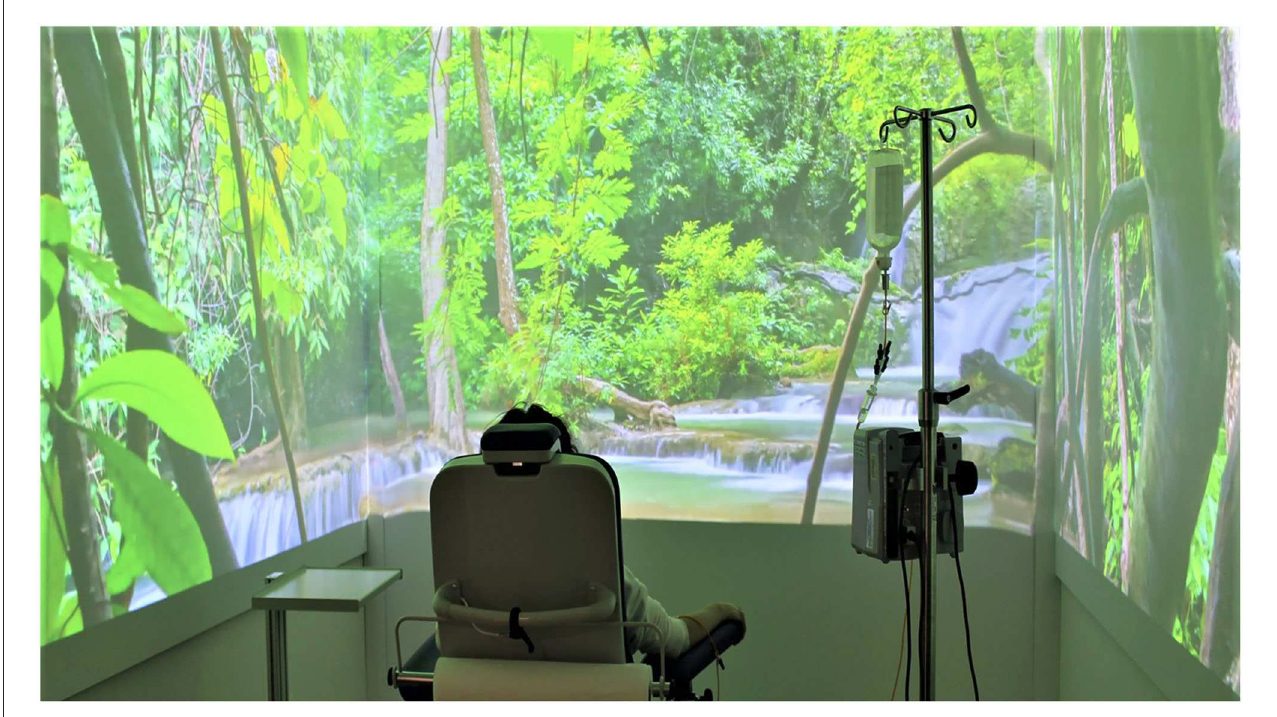
FIGURE5 Multimedia immersive room use during chemotherapy.